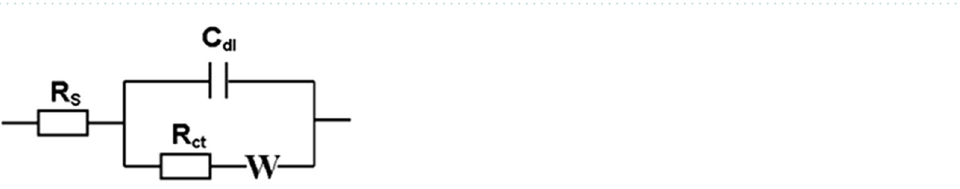
Figure 6. Nyquist plots of Au and Pt electrodes recorded using sweat and saliva bio-mimic solutions at half- wave potentials (E 1/2 ). ( A ) Au and ( B ) Pt electrodes’ impedance responses obtained in artificially simulated sweat solution + Fe 2+/3+ redox couple. Similarly ( C ) Au and ( D ) Pt electrodes’ impedance data recorded in artificial saliva solution + Fe 2+/3+ redox couple. These curves are recorded using 1 mM [Fe(CN) 6 ] 3−/4− redox couple containing 0.1 M NaCl in absence (a) and in presence (b) of either sweat or saliva compositions respectively.